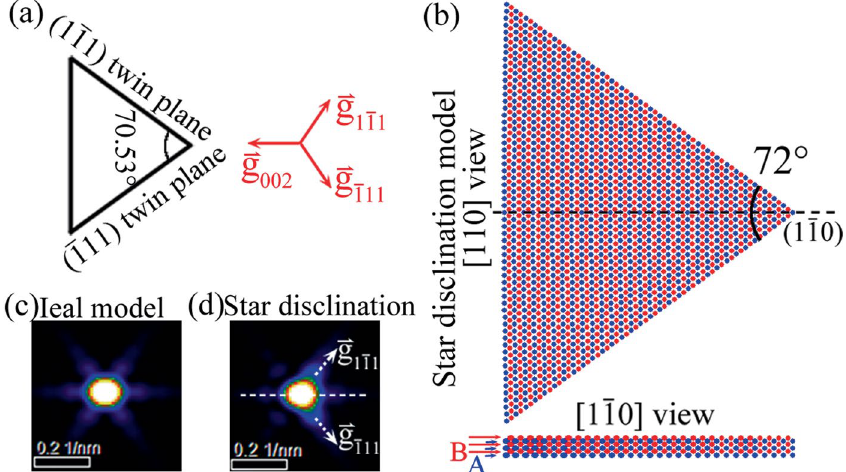
Figure 4. Kinematic electron diffraction simulation for the ideally unrelaxed structural model and the star- disclination model. ( a ) The schematic cross-sectional view of ideally unrelaxed structural model (left part) and the corresponding reciprocal orientation (right part). ( b ) The star-disclination atomic configuration viewing along [110] and [110] direction, respectively. In the [110] view, only four (110) layers are demonstrated. The (110) planes pack as the sequence of ABAB …… . To clearly see this packing sequence in the [110] project view, the Ag atoms in A and B layers have been colored with blue and red, respectively. ( c ) and ( d ) demonstrate the kinematic electron diffraction simulation result of the 2D intensity map of (331) reflection in the Ω plane according to the ideal model ( a ) and the star-disclination model ( b ),